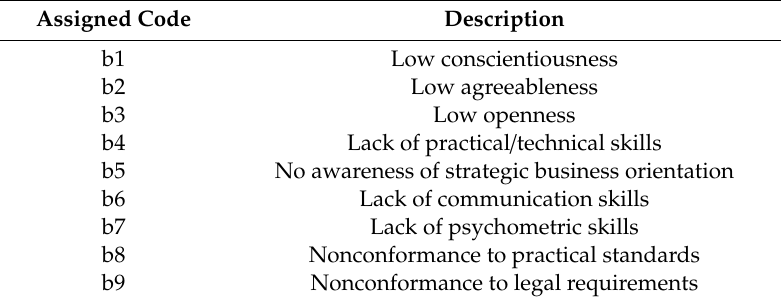
Table 6. Assigned codes and descriptions of individual barriers’ basic events.